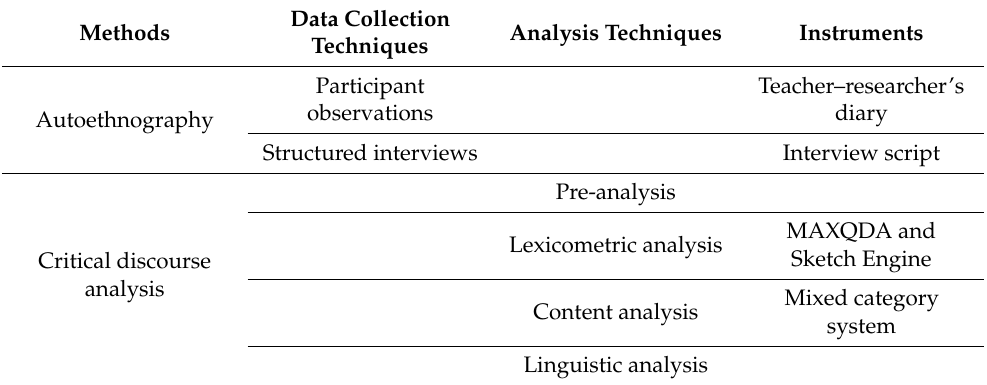
Table 2. Relationships among the methods, techniques, and instruments used in the